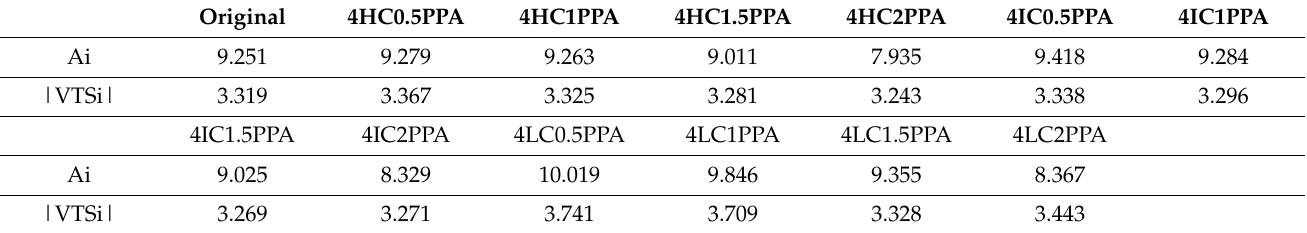
Table 5. ASTM Ai-VTSi values for original and modified bitumen.